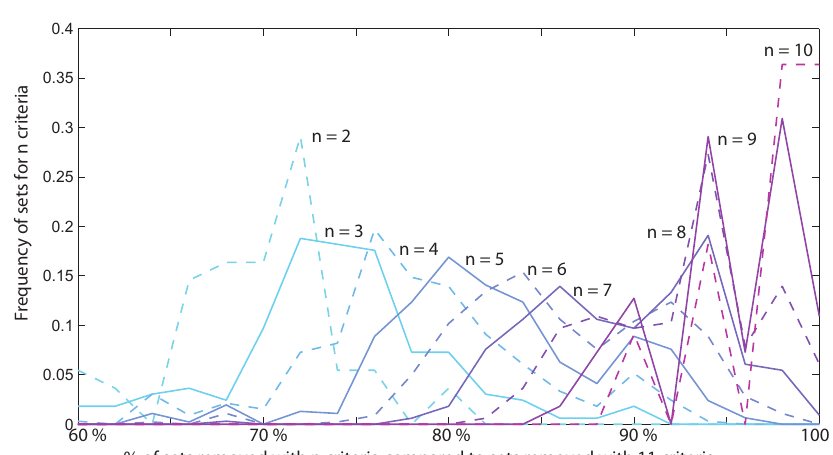
Figure B1. This figure compares the number of non-behavioral sets removed by subsets of different metrics benchmarked by the number of non-behavioral sets removed by all 11 criteria. Distributions for a given subset of metrics ( n = 2 to n = 10) are shown for all possible combinations of